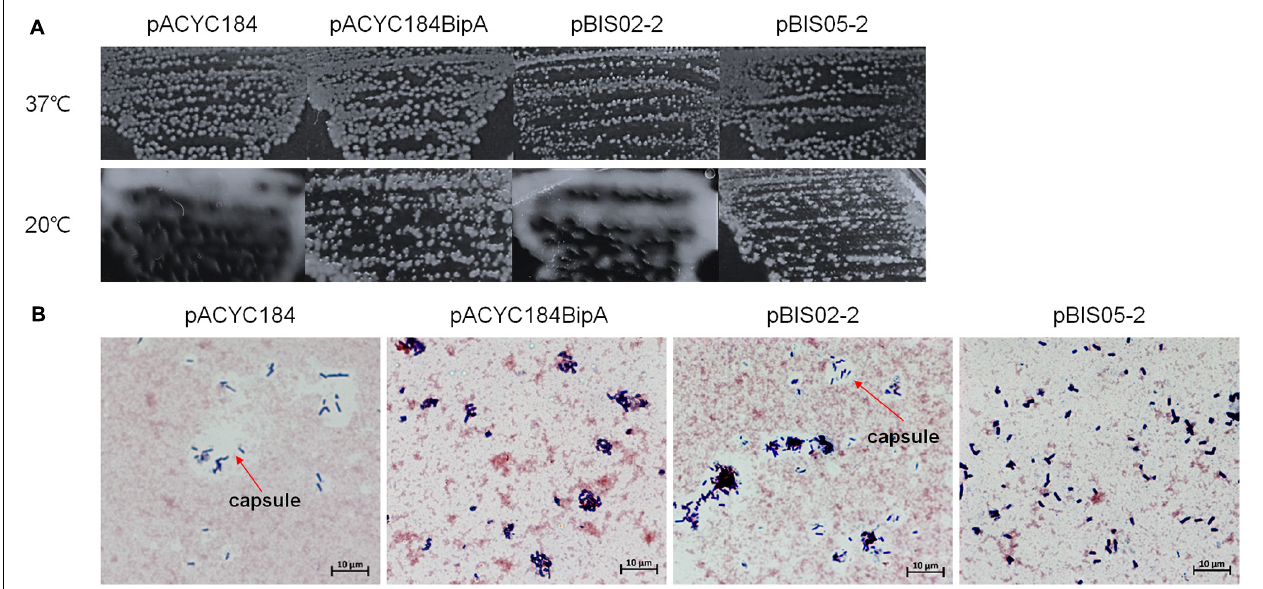
FIGURE 3 | Colony morphologies of the ESC19 transformants. (A) ESC19 cells transformed with pACYC184, pACYC184BipA, pBIS02-2, or pBIS05-2 were grown on LB agar plates supplemented with the appropriate antibiotics overnight at 37 ◦ C or 4 days at 20 ◦ C. The suppressor clone (pBIS02-2) expressing r-protein L20 was tested as a mucoid suppressor. (B) Capsule staining by crystal violet and Congo red. Colonies from LB plates incubated at 20 ◦ C for 4 days were stained and observed as described in section “Materials and Methods.” Arrows indicate